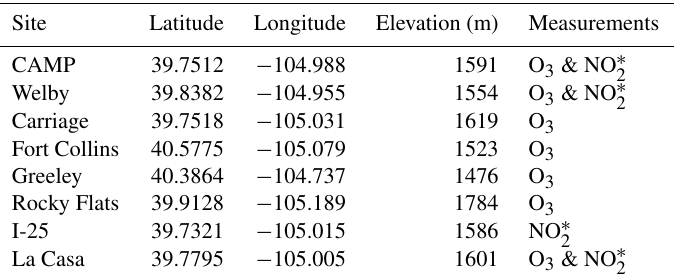
Table 1. Summary of measurement sites used in this analysis. Note that NO ∗ Method and thus includes a fraction of NO y species.